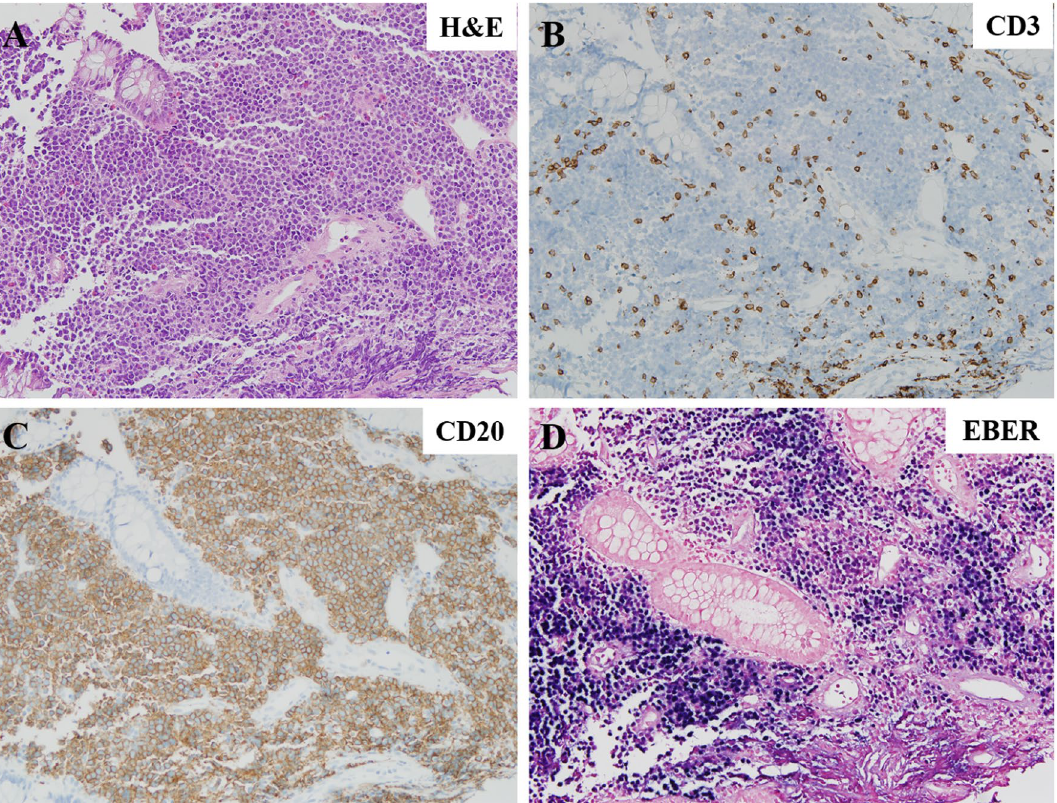
Figure 4. Histologic examination of a monomorphic PTLD–DLBCL involving terminal ileum ( A ) hematoxylin and eosin, original magnification ×200, ( B ) tumor cells were negative for CD3, ( C ) while positive for CD20 and ( D ) EBER. PTLD post-transplantation proliferative disorder, DLBCL diffuse large B-cell lymphoma, EBER Epstein-Barr Virus-encoded small ribonucleic